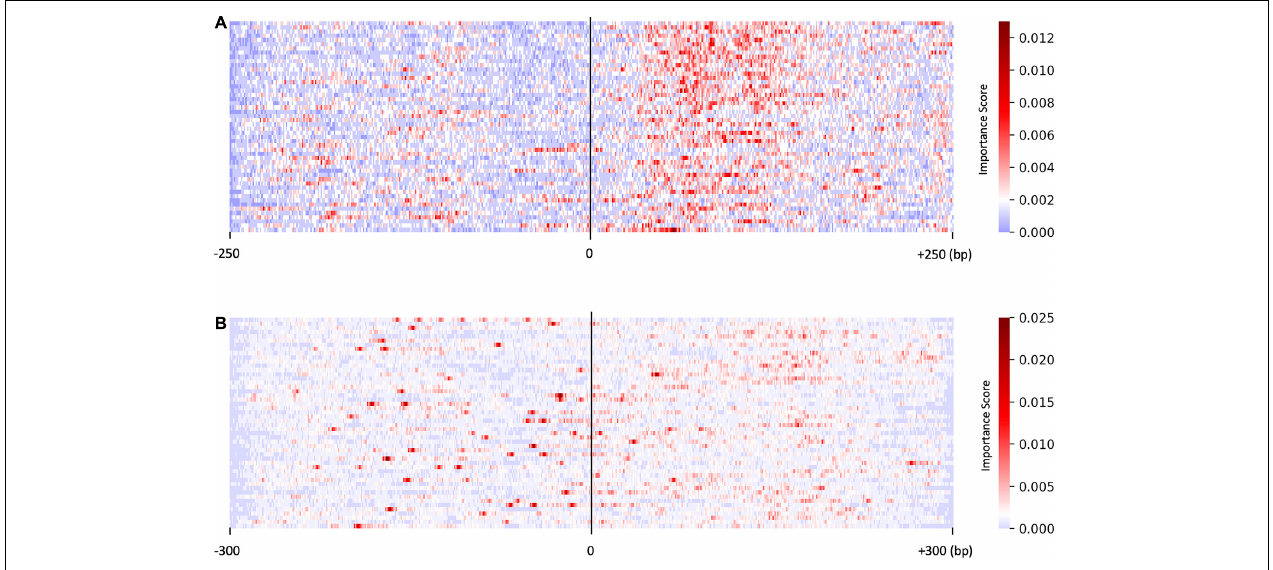
FIGURE 2 | Results of the saliency map showing the importance score of each nucleotide in the top 50 predicted promoter regions with US_UU dataset (A) and CAGE dataset (B) . The x -axis represents relative positions from the midpoint between the bidirectional transcriptional start site (TSS). The color scale corresponds to the normalized importance score; US, unstable-stable TSS pair; UU, unstable-unstable TSS pair.